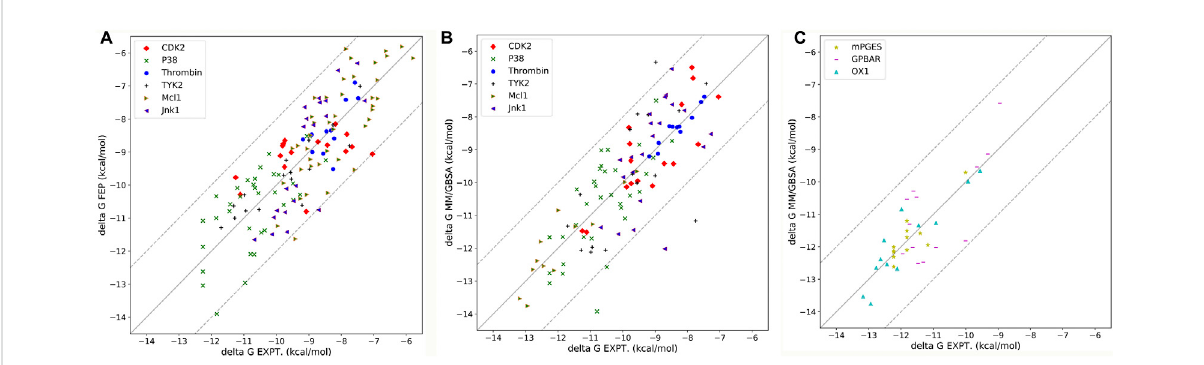
FIGURE 4 (A) Correlation between FEP-predicted binding free energies and experimental data for six soluble protein systems. Data is reported by Wang etal.,2015. (B) CorrelationbetweenMM/GBSA-predictedbindingfreeenergiesandexperimentaldataforsixsolubleproteinsystems. (C) Correlation between MM/GBSA-predicted binding free energies and experimental data for three membrane protein